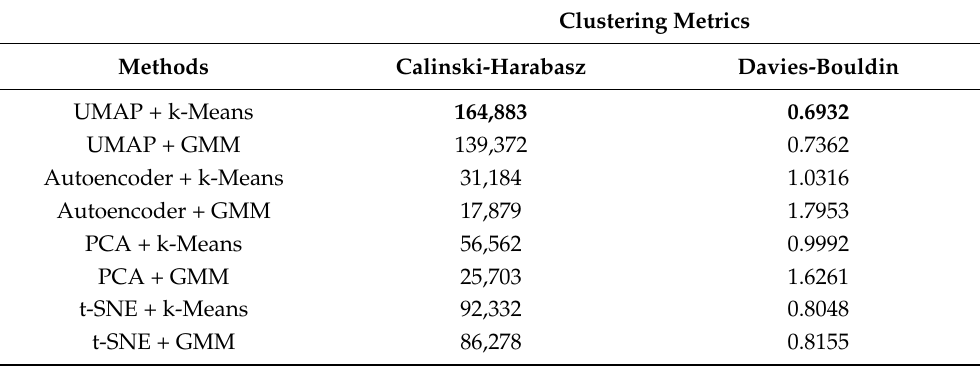
Table A3. Mean of the Calinski-Harabasz and Davies-Bouldin criterion over a range of 5 to 20 clusters for the FRT0001c71b dataset, split by method. The best score for each coefficient is in